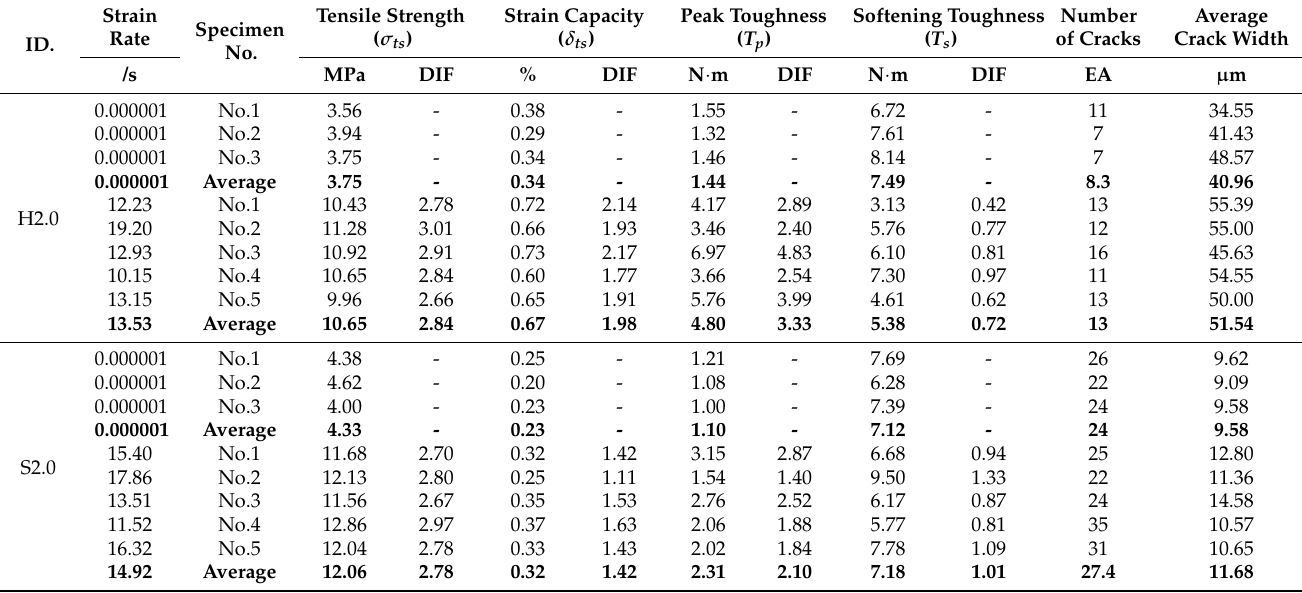
Table 5. Tensile properties of HP-MFRCC.